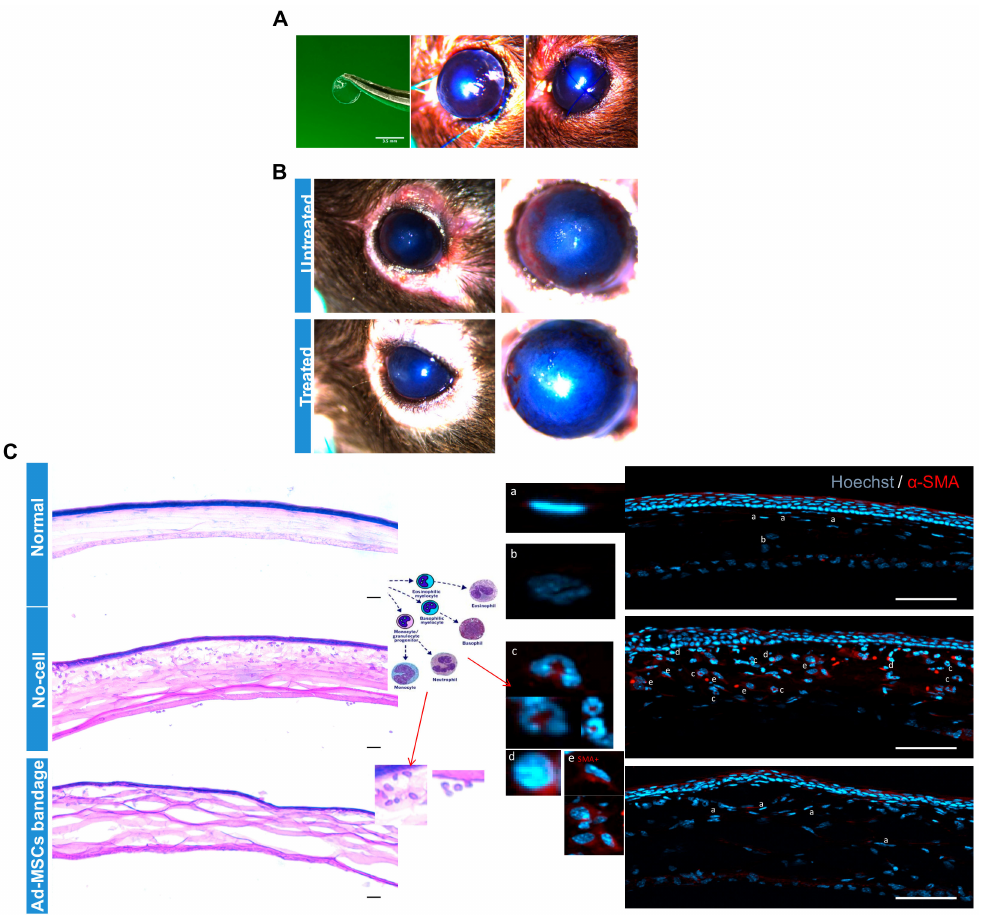
Figure 7. In vivo study: Epithelial debrided mouse corneas treated with alginate bandages with or without adipose-derived mesenchymal stem cells (Ad-MSCs). Ad-MSCs were encapsulated in calcium alginate gels (approx. 1 mm thickness) at a density of 20 × 10 6 cells / mL and stored for 3 days at 15 ◦ C. ( A ) Following epithelial debridement injury to the cornea, 3.5 mm diameter gels either without cells (untreated) or with cells (treated) were punched out and applied directly to the wounded cornea, and the eyelids were sutured closed. ( B ) Gels were left in situ for 4 days, following which the suture and gel were removed and the eye evaluated. ( C ) Eyes were imaged at 7 days post-injury before being enucleated and processed for histological analysis. H&E staining and immunofluorescence showed low levels of immune cells in the normal and Ad-MSC bandage-treated injured corneas but high levels of monocytes and neutrophils (Cc and Cd) in the untreated corneas. α SMA expression by keratocytes was absent in the normal and Ad-MSC bandage treated corneas (C and Ca) but present in the untreated corneas (C and Ce). Scale bar = 50 µ m. α SMA: alpha smooth muscle